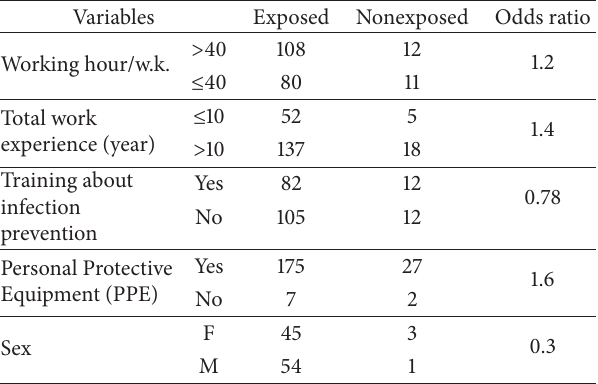
Table 3: Association of variables with risky occupational exposure to needle stick injury, glove breakage, and contact potentially infectious blood and other body